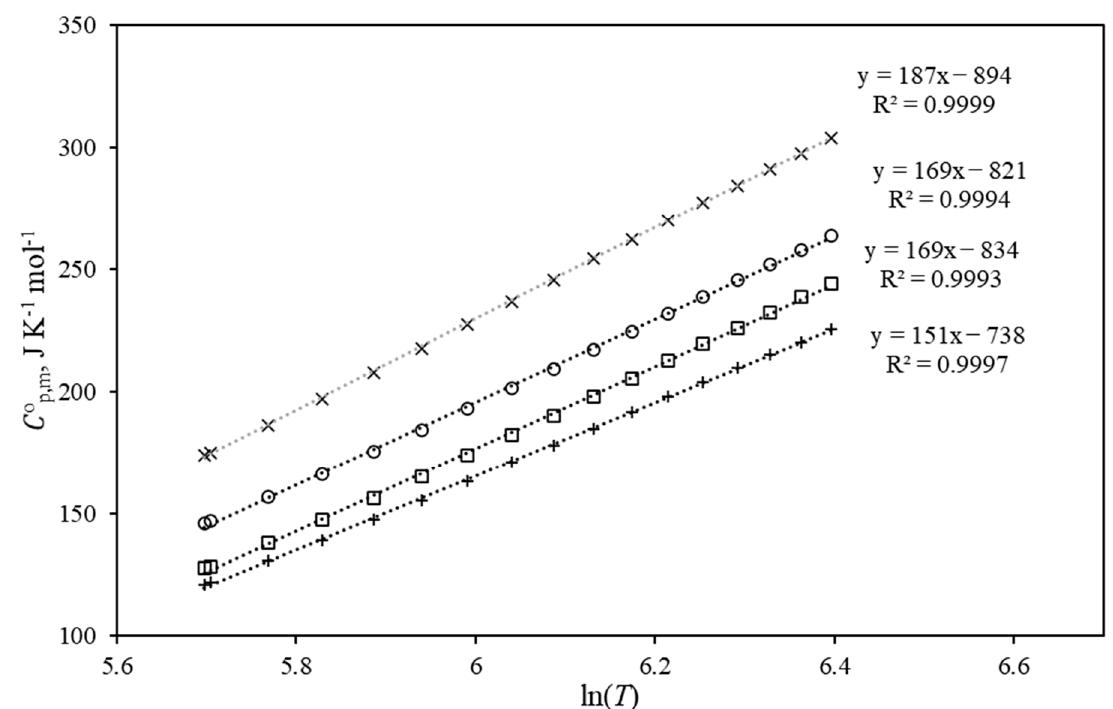
Figure 11. The gas-phase heat capacities of the aromatic counterparts of the LOHC systems approximated by Equation (29): □ —indoline, ○ —2Me-indole, ×—2-Me-indoline, +—indole.